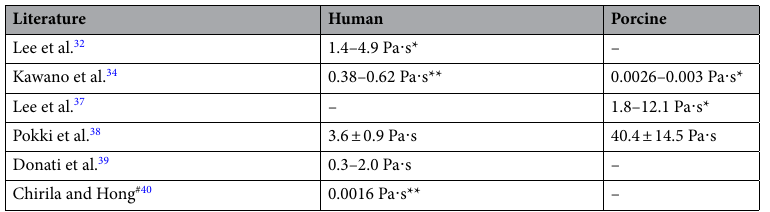
Table 2. Viscosities of human and porcine vitreous body from the literature. *Apparent viscosity: The vitreous body exhibits non-Newtonian rheological properties based on spatially varying concentrations of hyaluronic acid and collagen 32,34,37 . **Dynamic viscosity: The vitreous body exhibits rheological properties as a Newtonian fluid adopted to Newtons law 34,40 . # Values from 40 describe the viscosity of "aspirated" human vitreous body (Reference by Shafer 41